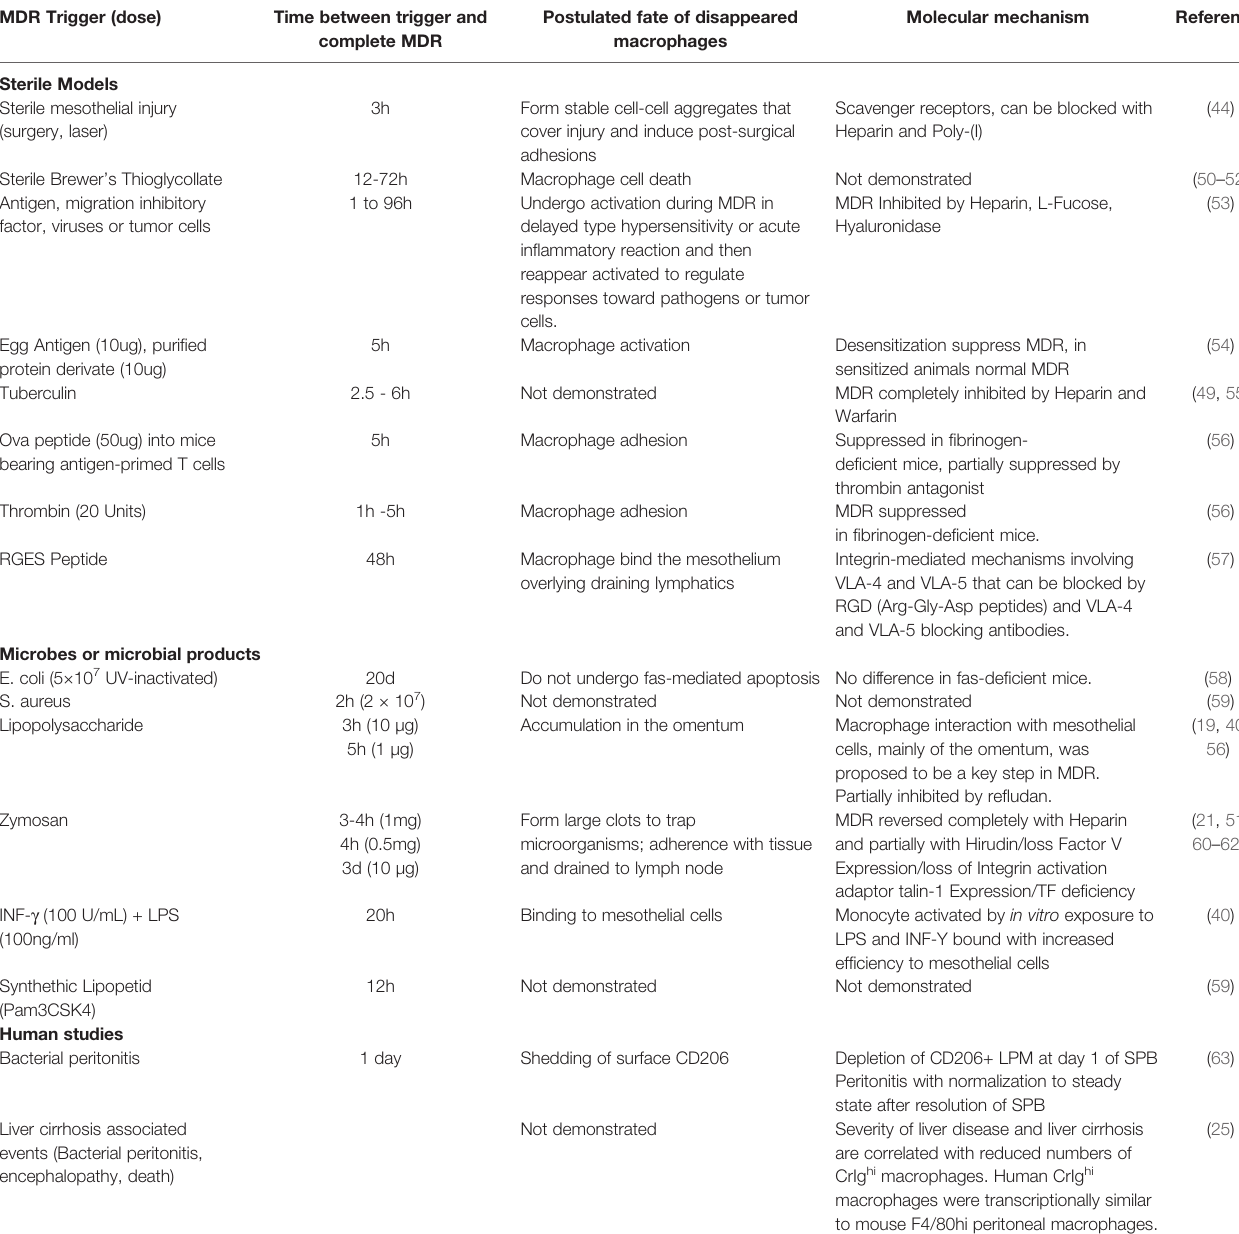
TABLE 1 | Macrophage disappearance reaction (MDR). Studies describing MDR from 1963 until